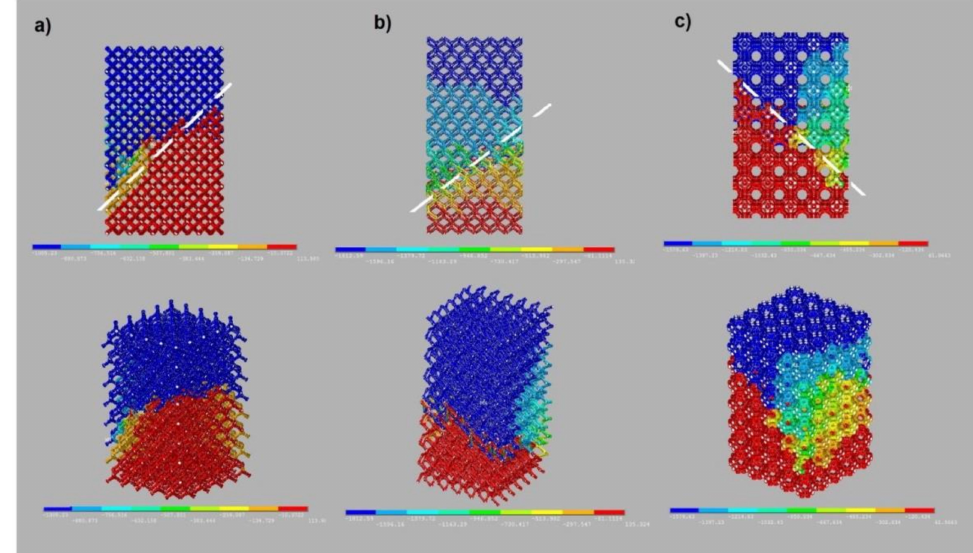
Figure 21. Fatigue failure surface of ( a ) diamond structure, ( b ) rhombic dodecahedron, and ( c ) truncated cuboctahedron structure. Reprinted with permission from ref. [57]. 2015, Elsevier.